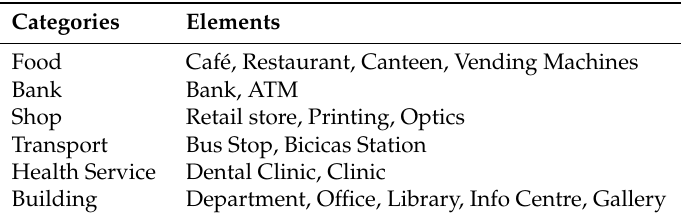
Table 1. Categories and elements used in the ARUJI